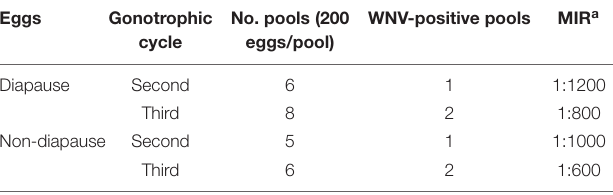
TABLE 2 | West Nile virus (WNV) detection in diapausing eggs of Ae. Albopictus Beijing strain. Eggs Gonotrophic cycle